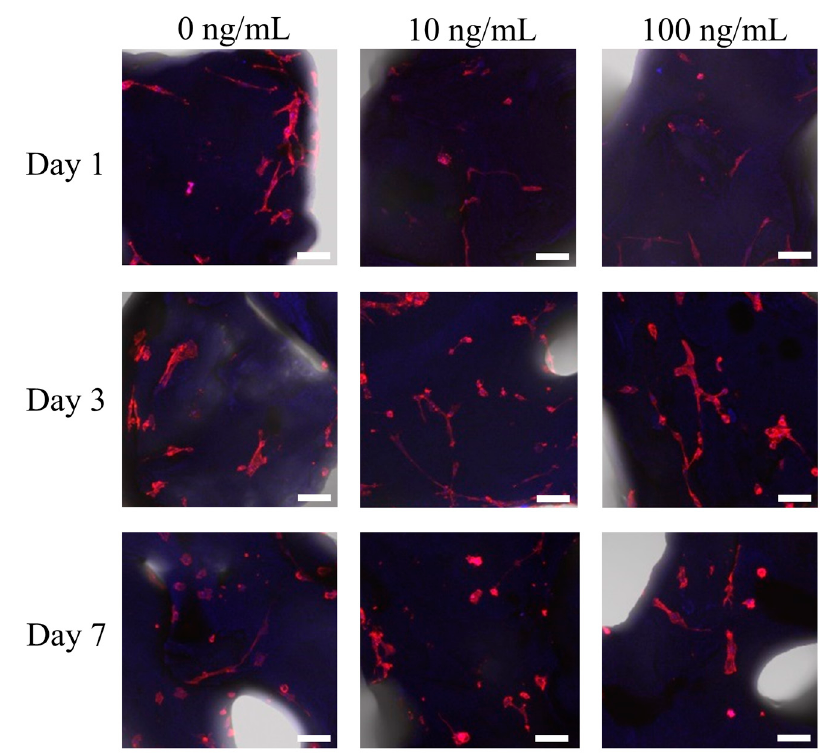
Figure 1. Stem cell attachment to the deproteinized bovine bone mineral. Scale bar indicates 100 µ m (original magnification: x50).